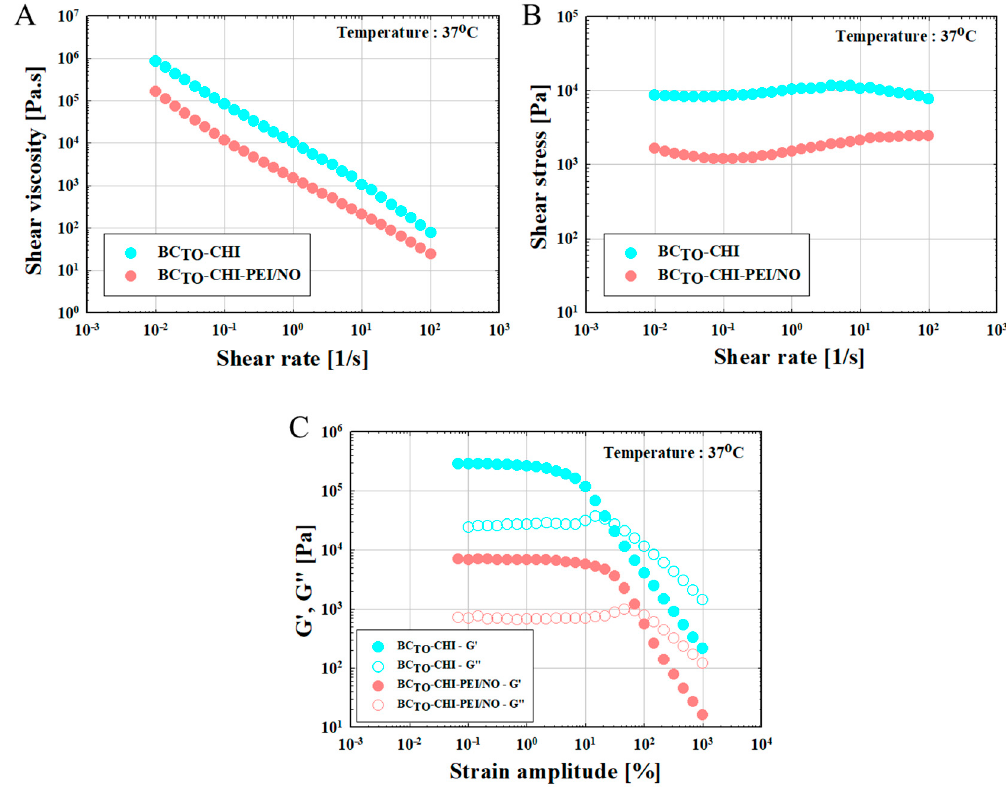
Figure 4. Rheological properties of test samples. ( A ) Shear viscosity of BC TO -CHI and BC TO -CHI- PEI/NO hydrogels following simulated wound fluid (SWF) absorption at the maximum swollen condition per weight as a function of the shear rate. ( B ) Shear stress vs. shear rate. ( C ) Storage modulus ( G ′ ) and loss modulus ( G ″ ) of BC TO -CHI and BC TO -CHI-PEI/NO hydrogels at 220% swollen condition as a function of the strain amplitude.